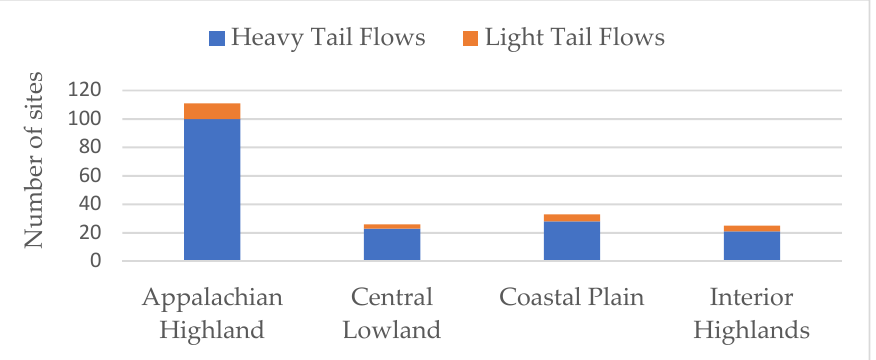
Figure 14. Number of sites with heavy and light tail flows of the bridge collapse sites across different regions.